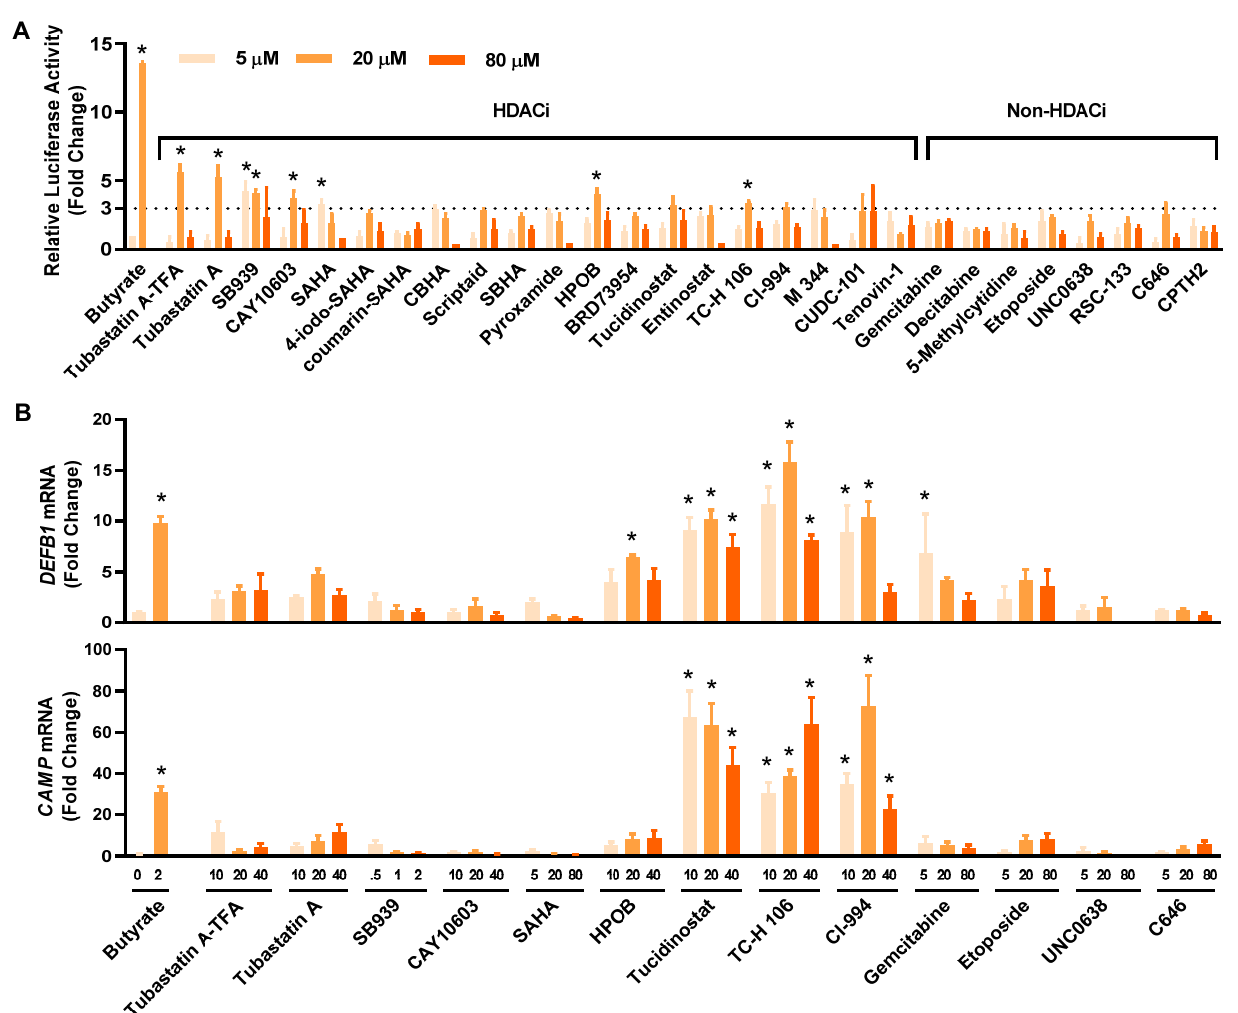
Figure 3. Confirmation of the HDP-inducing activity of the hit compounds. ( A ) Fold changes in the relative luciferase activity of 28 hits in HT-29/DEFB1-luc reporter cells stimulated with each compound at 5, 20, and 80 µ M for 24 h, followed by the cell viability and luciferase assays. Sodium butyrate (16 mM) was used as a positive control. The hits consisted of 20 HDACi and eight other epigenetic compounds. ( B ) Fold changes in DEFB1 and CAMP mRNA expression levels in response to 14 selected hits. HT-29 cells were stimulated with or without indicated concentrations ( µ M) of each compound for 24 h, followed by RT-qPCR analysis of gene expression. Sodium butyrate (2 mM) was used as a positive control. The results are means ± SEM of 2–3 independent experiments. Statistical significance was determined by one-way ANOVA and post hoc Dunnett’s test. * p < 0.05 compared with the nonstimulated